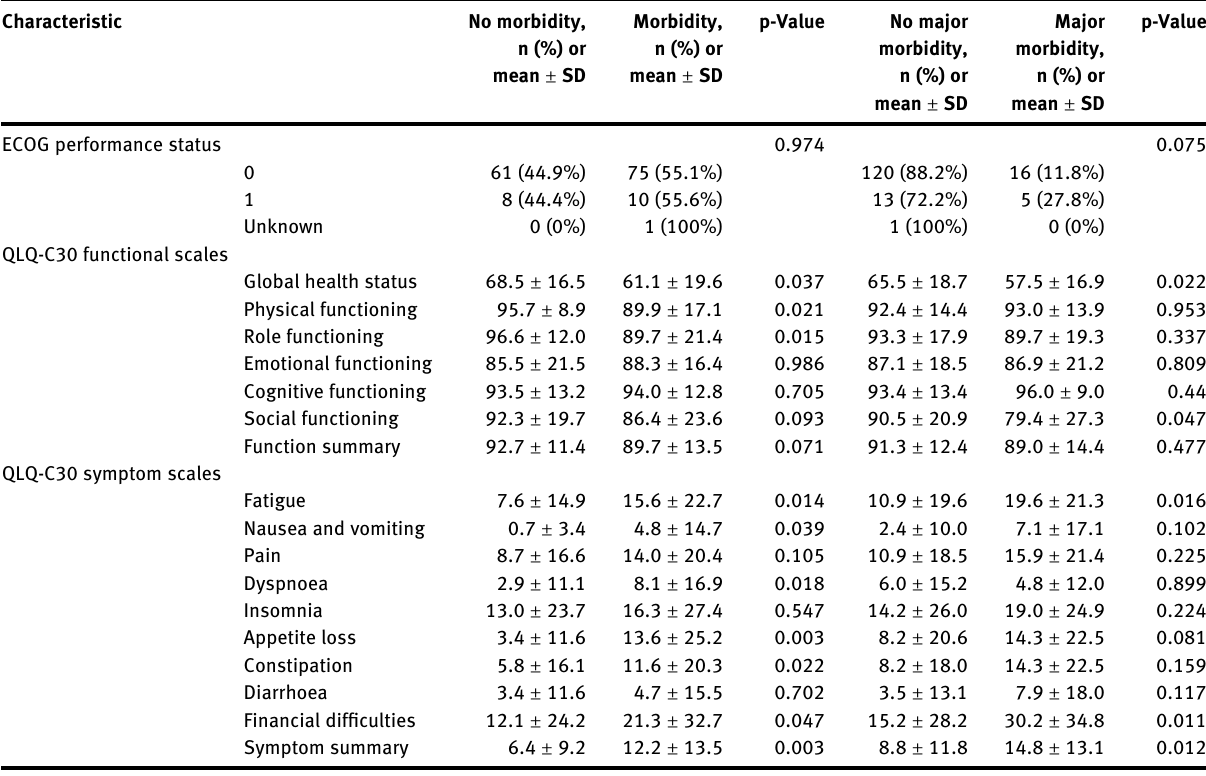
Table  : Association between ECOG performance status, QoL at baseline and morbidity. Morbidity was associated with signi fi cantly lower global health status, physical functioningand role functioning scores, and signi fi cantly higher symptom summary score, fatigue, nausea and vomiting,dyspnoea,appetiteloss,constipationand fi nancialdif fi cultiesscoresatbaseline.Majormorbiditywasassociatedwithsigni fi cantly lower global health status and social functioning scores, and signi fi cantly higher symptom summary score, fatigue and fi nancial dif fi culties scores at